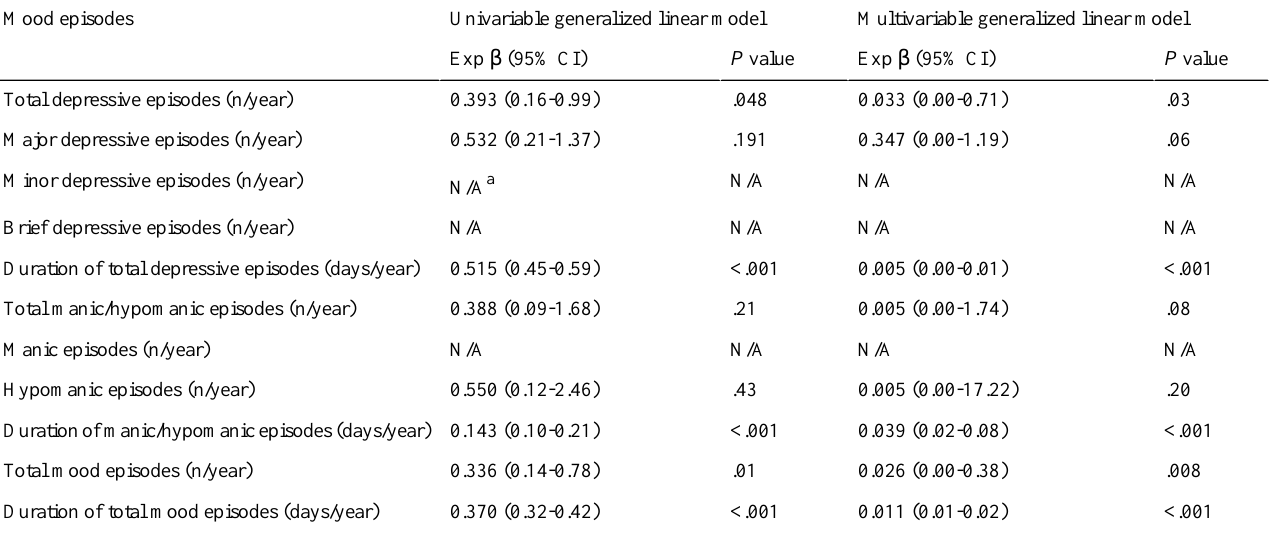
Table 2. Comparison of the recurrence of mood episodes between the circadian rhythm for mood group (n=10) and the non–circadian rhythm for mood group